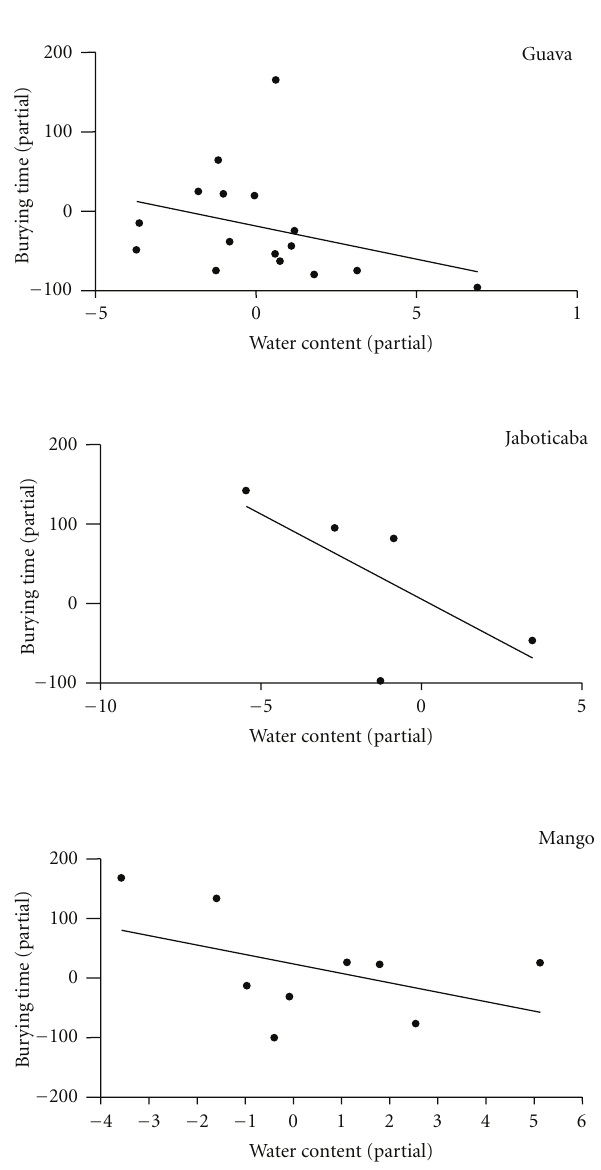
Figure 3: Average time until fruit fly larvae bury themselves through gradient of water content of soil beneath the crowns of three species of fruit trees. Only larvae that were not predated by ants were included. Partial residuals were obtained from a multiple-linear model that included compaction of soil (no significant e ff ect). Guava is Psidium guajava , jaboticaba Myrciaria jaboticaba , and mango Mangifera indica